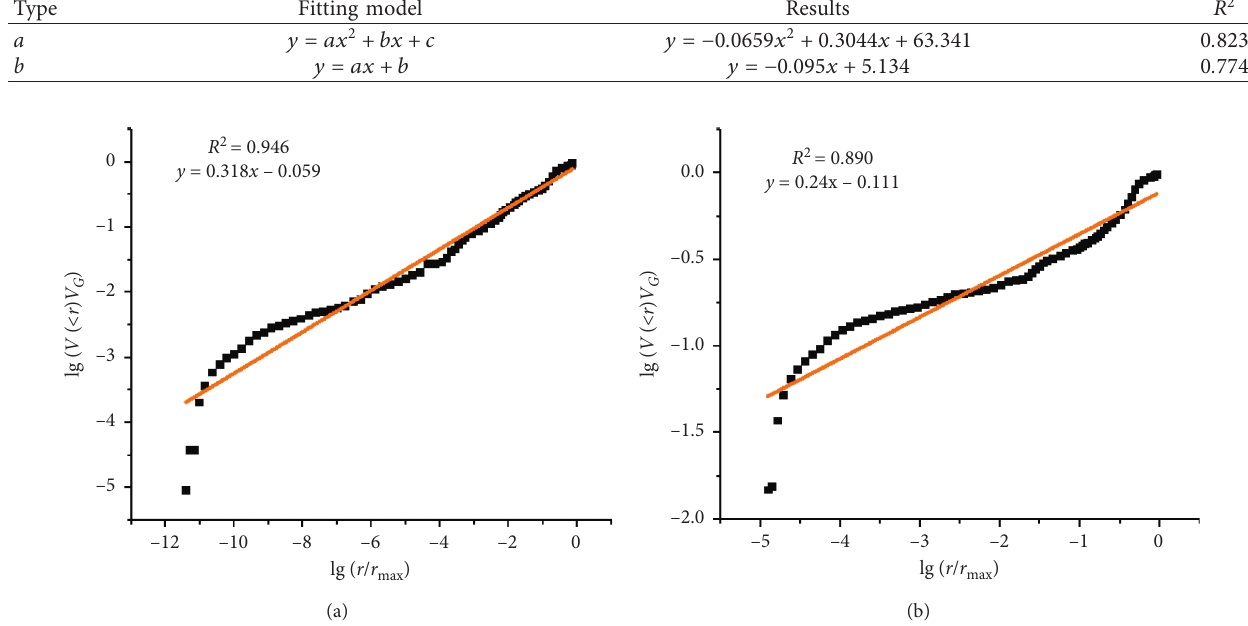
1 B 1 C 1 D 1 and . (b) A 1 B 2 C 2 D 2 .